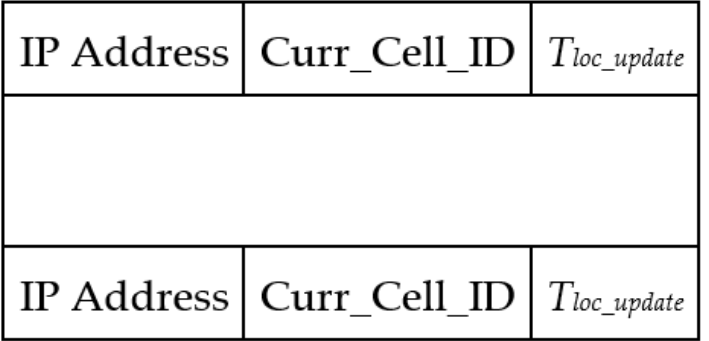
Figure 5. Data table format for storing the location information of UAVs.